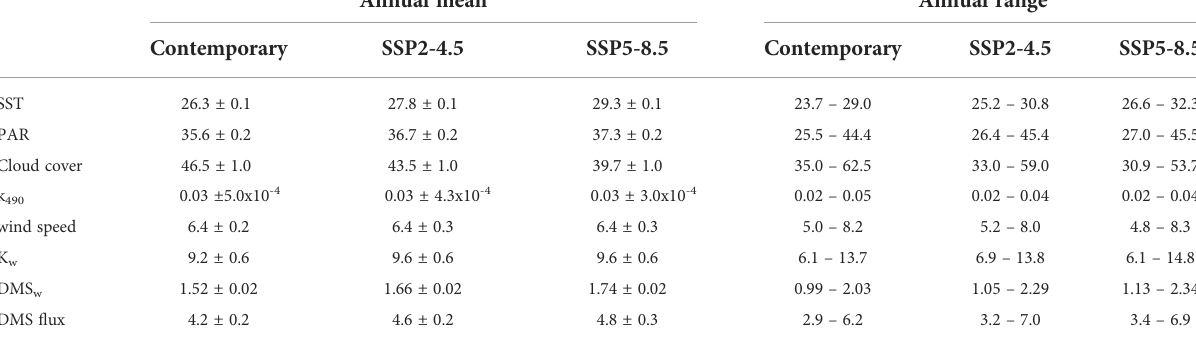
TABLE 2 Climatological annual mean (± 2 standard errors) and range for variables area-averaged over the GBRMP for the contemporary (2001- 2020) and end of century (2081-2100)